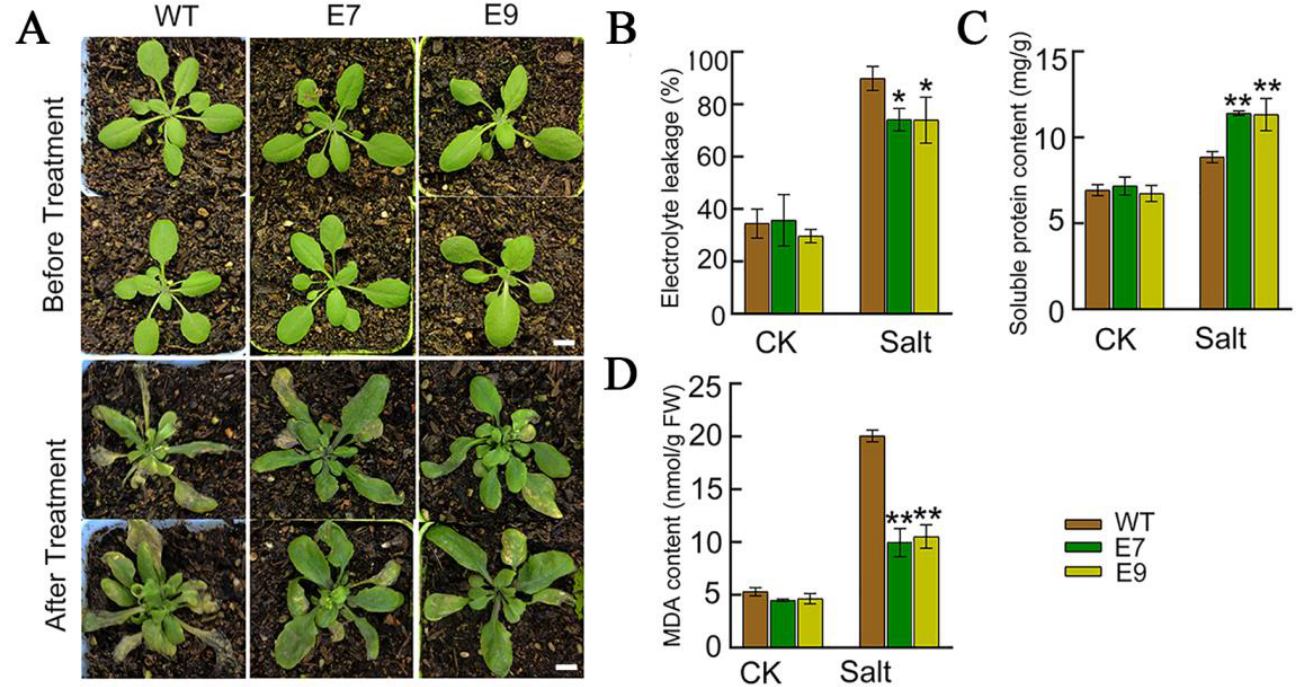
Figure 6. Overexpression of OfELF3 promotes salt tolerance of A. thaliana . ( A ) The phenotype of three-week-old plants under salt treatment. Scale bars = 1 cm. ( B – D ) Relative electrolyte leakage ( B ), MDA content ( C ), Soluble protein content ( D ) of WT and OfELF3 transgenic lines under salt stress conditions. * p < 0.05, ** p < 0.01, t test.